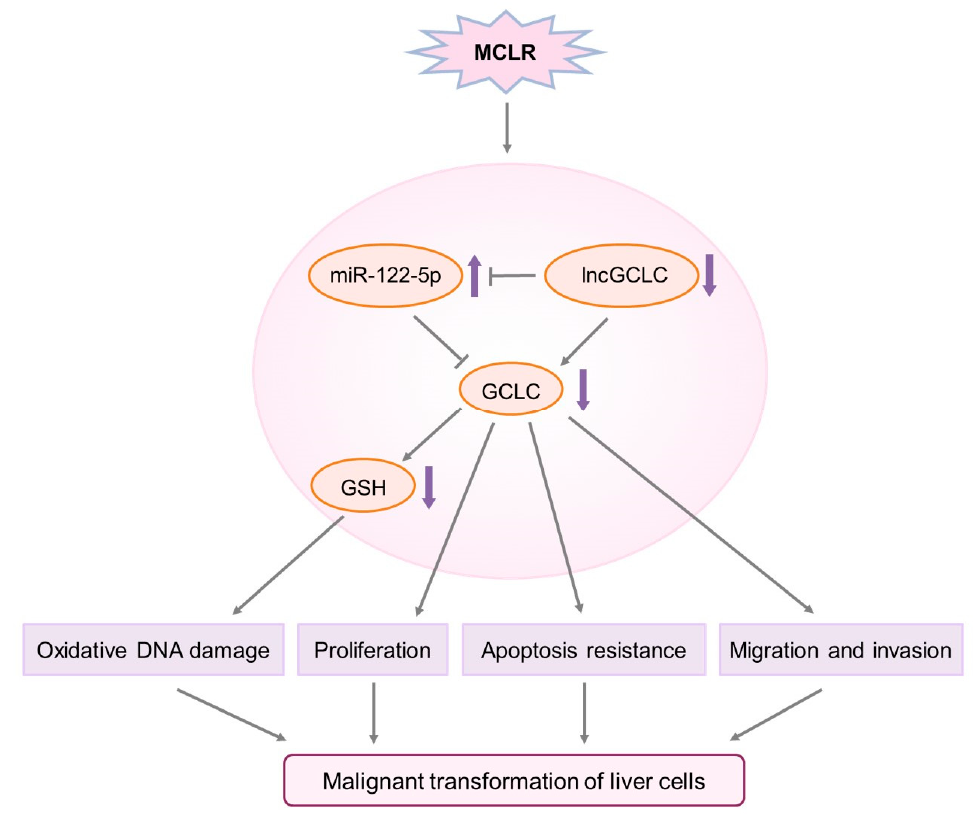
Figure 7. Schematic diagram for the role of lncGCLC pathway in MCLR-induced malignant transformation. Supplementary Materials: The following supporting information can be downloaded at: https: //www.mdpi.com/article/10.3390/toxics11020162/s1, Table S1: Primer sequences used in the exper- iment; Table S2: Clinicopathologic factors of hepatocellular carcinoma patients with MC exposure; Figure S1: Comparison of tumor weight (A) or volume (B) between male and female nude mice in each group after inoculation for 22 days. ND—not